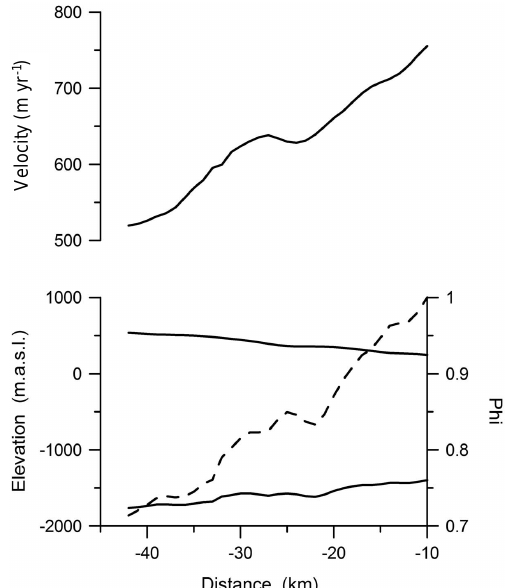
Figure 1. Geometry of the lower part of Byrd Glacier, East Antarc- tica. The dashed line in the lower panel shows the buoyancy factor, calculated from Eq. (12).